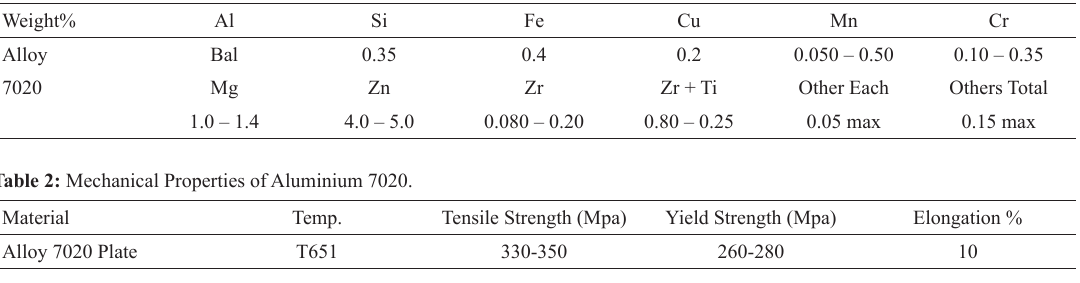
Figure 1: Experimental Setup and Tool profile. Table 1: Chemical Composition of Aluminium Alloy 7020.